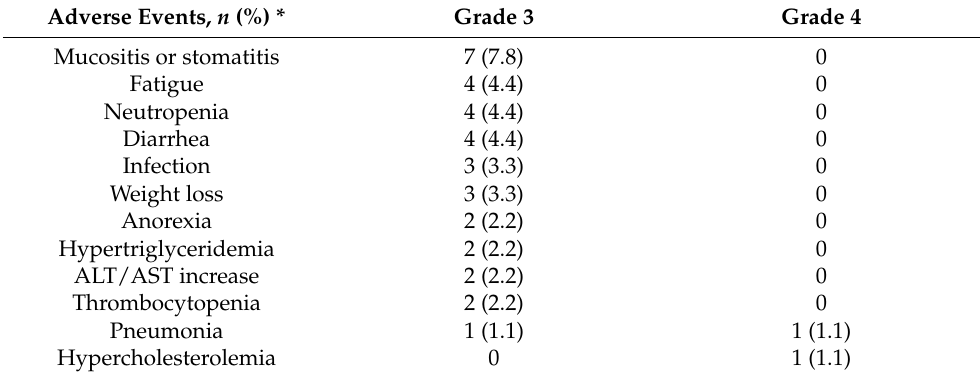
Table 1. Grade 3 or grade 4 adverse effects of Everolimus for ATC patients